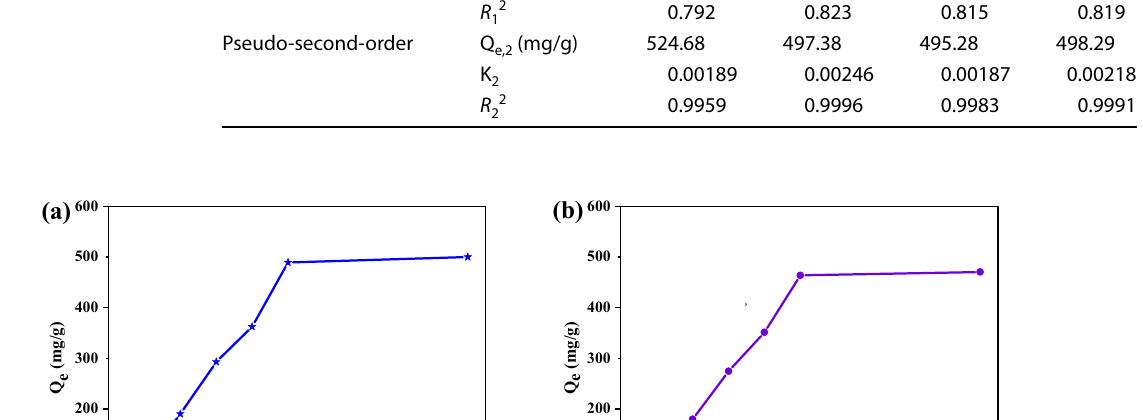
Table 1 Fitting parameters of PAA/PAM/[DMAEMA]MA hydrogel for MB, RHB, CR and EB adsorption kinetics